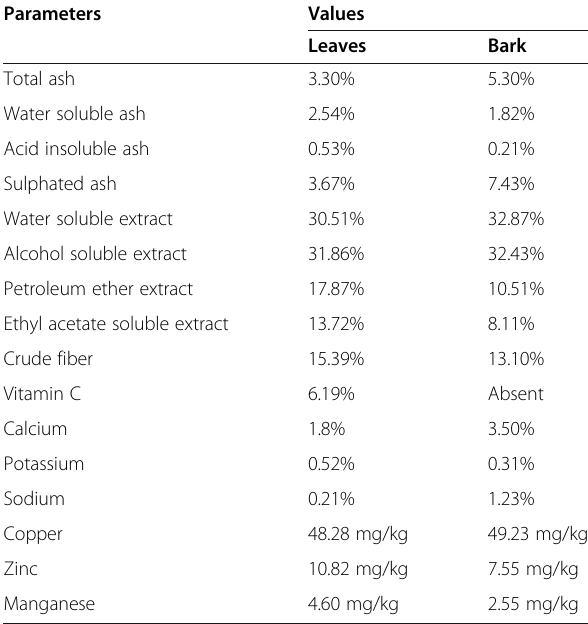
Table 2 Physicochemical analysis of S . palghatense leaves and bark Parameters